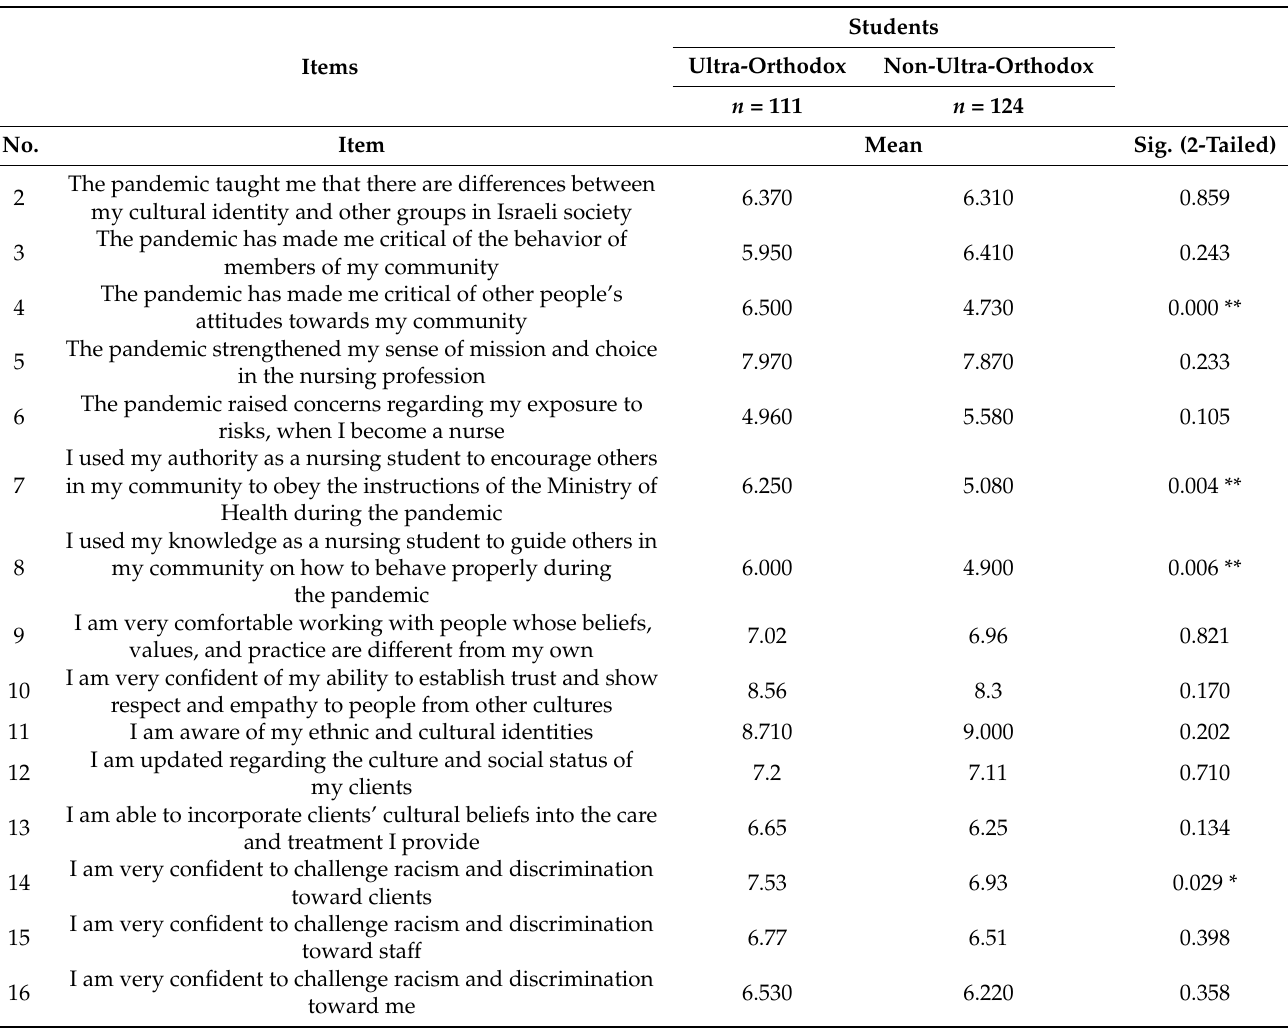
Table 4. Independent Samples Test